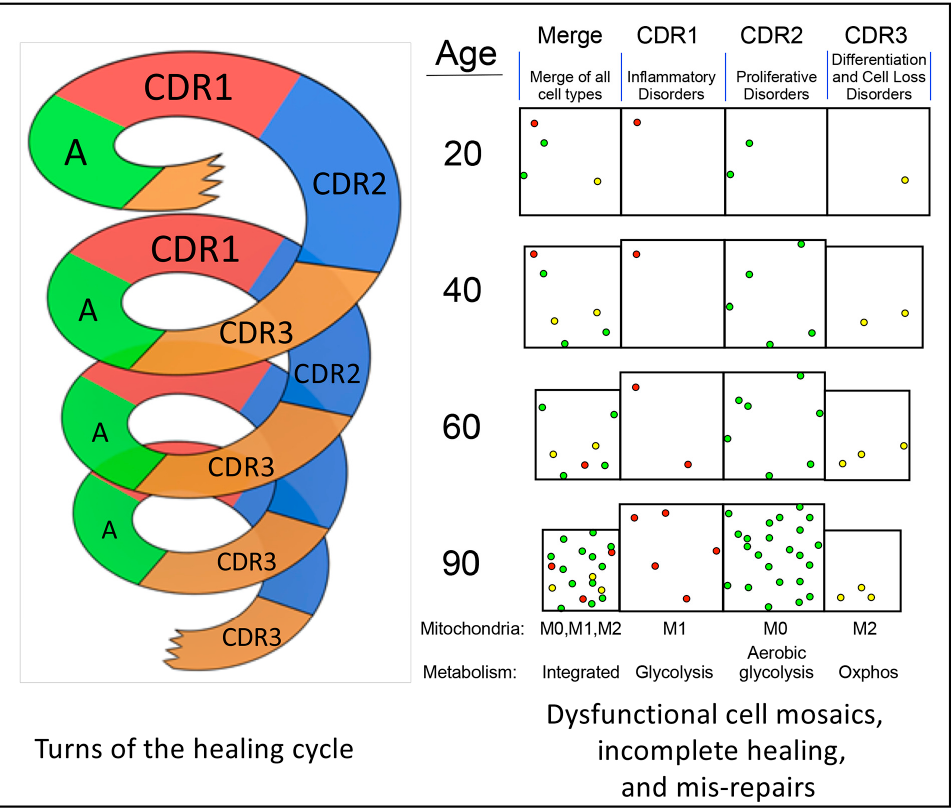
Figure 2. Repeated cycles of incomplete healing lead to aging and age-related disease. The spiral represents sequential turns of the healing cycle throughout life. Colored cells in the boxes on the right represent cells that have been delayed or arrested in a stage of the healing cycle. The decreased size of some boxes represents the loss in tissue volume from cell loss and atrophy. In this example, most arrested or delayed cells in the merge on the right after 60 and 90 years are in CDR2 (green). This will create an increased risk of proliferative disorders such as diabetes, heart disease, and cancer. Color code: CDR1 cells—red; CDR2 cells—green; CDR3 cells—yellow. Abbreviations: A—wakeful activity and nutrient intake. M1—mitochondria adapted for cell defense, reactive oxygen, nitrogen, and aldehyde production; M0—mitochondria adapted for cell growth and Warburg metabolism; M2—mitochondria adapted for oxidative phosphorylation (oxphos).